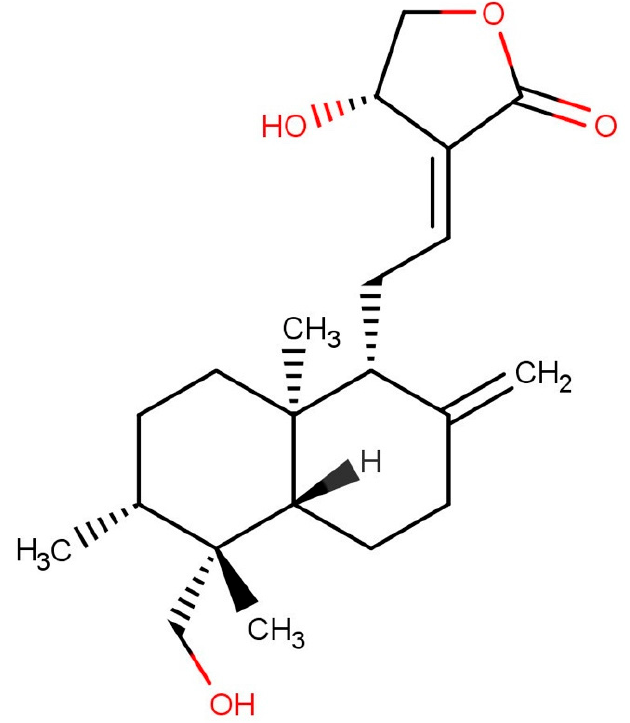
Figure 6. Chemical structure of andrographolide.